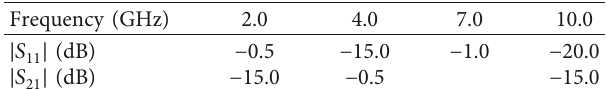
Table 3: Samples from the desired frequency response of S S 11